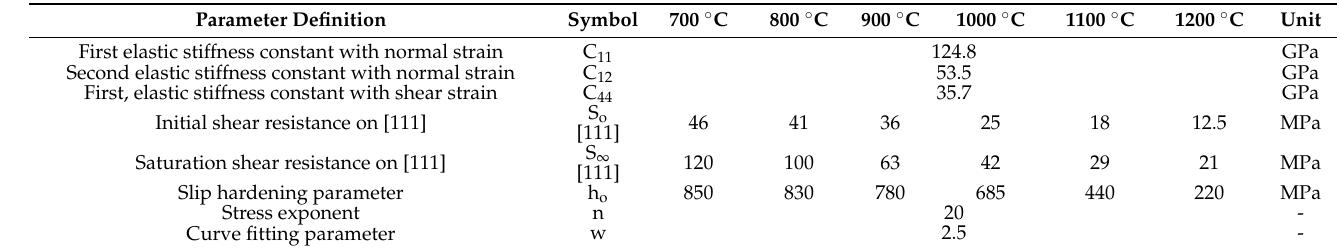
Table 2. The calibrated austenite matrix phenomenological material model parameters for different temperatures.